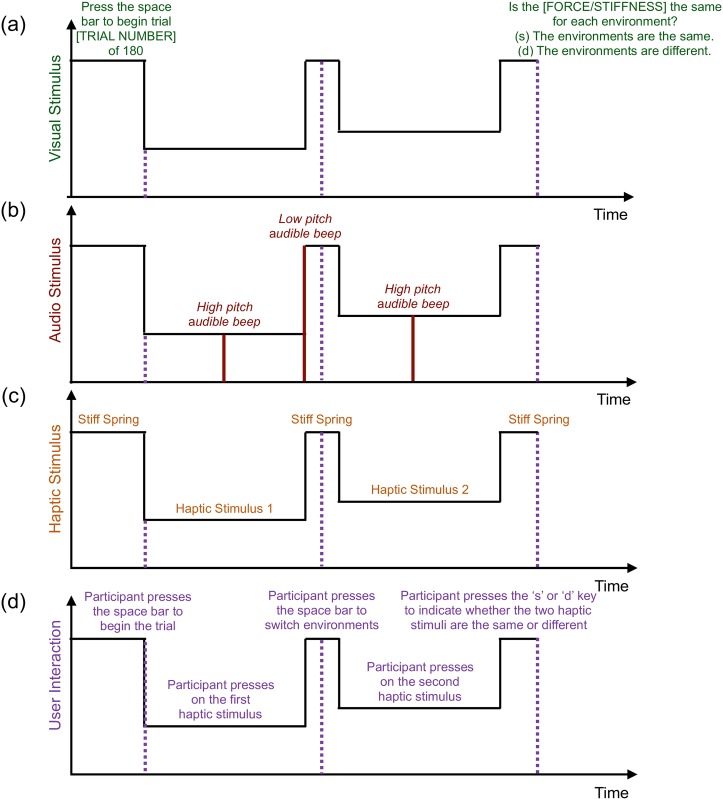
Trial timeline.Visual depiction of the (a) visual stimuli, (b) audio stimuli, (c) haptic stimuli, and (d) user interaction during the same-different task that a participant performs within a trial. The participant pushes the space bar with the left hand to begin the trial, then presses with the right index finger on the first haptic stimulus until an audible beep plays, and next returns the right index finger to the initial location. Following, the participant pushes the space bar with the left hand, waits 0.1 s, presses with the right index finger on the second haptic stimulus until an audible beep plays, and finally returns the right index finger to the initial location. Last, the participant responds whether the two haptic stimuli are the same by pushing the appropriate keyboard key with the left hand.